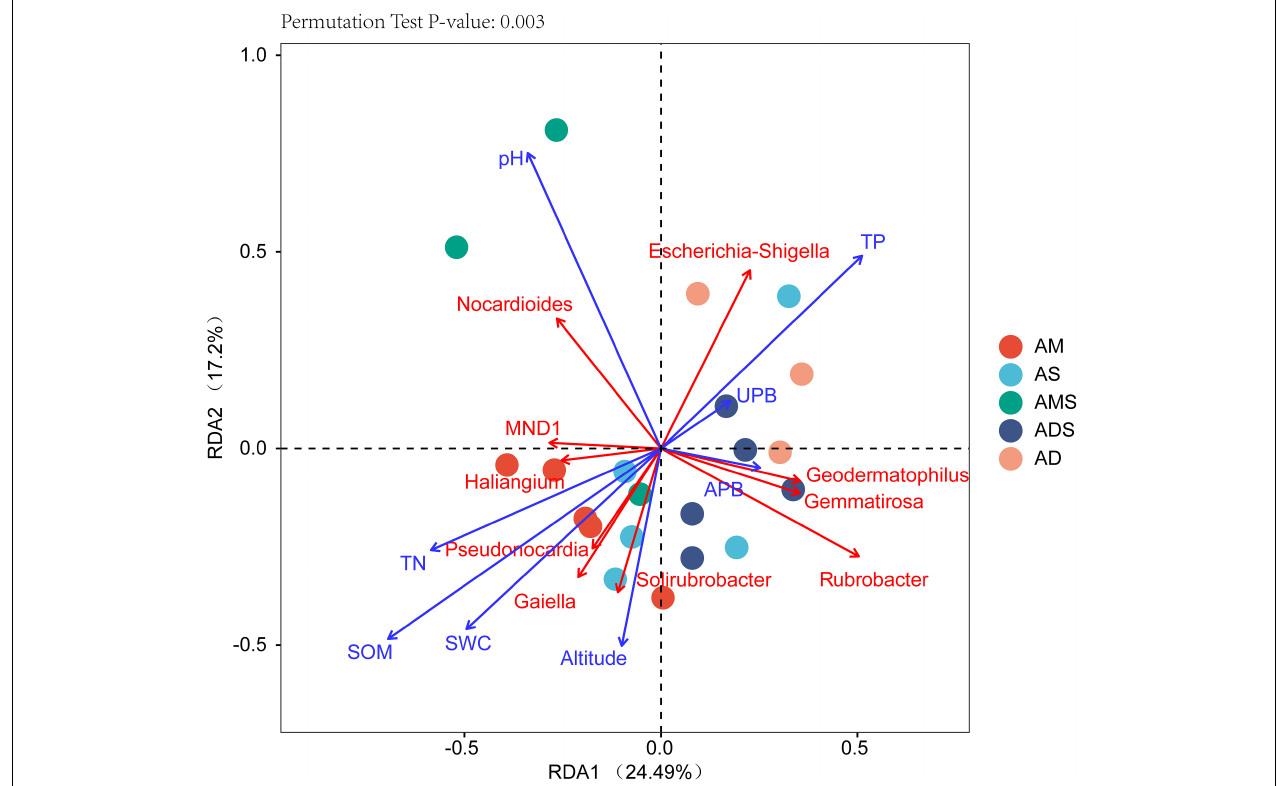
FIGURE 6 | Redundancy analysis (RDA) of soil bacterial communities and environmental factors in alpine grasslands on the Tibetan Plateau. Points of the same color with a symbol denote sampling sites of an alpine grassland type. The blue arrows represent environmental factors, the red arrows represent soil bacteria (genus), and the cosine of the angle within two vector arrows represents the correlation between vectors. AD, alpine desert; ADS, alpine desert steppe; AM, alpine meadow; AMS, alpine meadow steppe; AS, alpine steppe; APB, aboveground plant biomass; UPB, underground plant biomass; SOM, soil organic matter; TN, total nitrogen; TP, total phosphorus; SWC, soil water